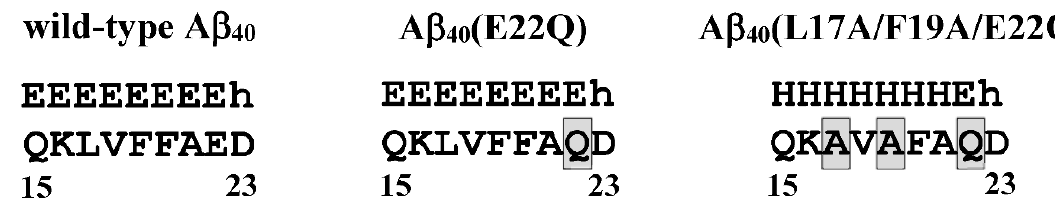
Figure 4. The predicted secondary structures of the α / β -discordant regions of wild-type A β 40 A β 40 (E22Q) and A β 40 (L17A / F19A / E22Q). β -strands predicted with high and low probability were denoted by the symbols E and e, respectively. α -helical structures predicted with high and low probability were denoted by the symbols H and h, respectively [31,36].